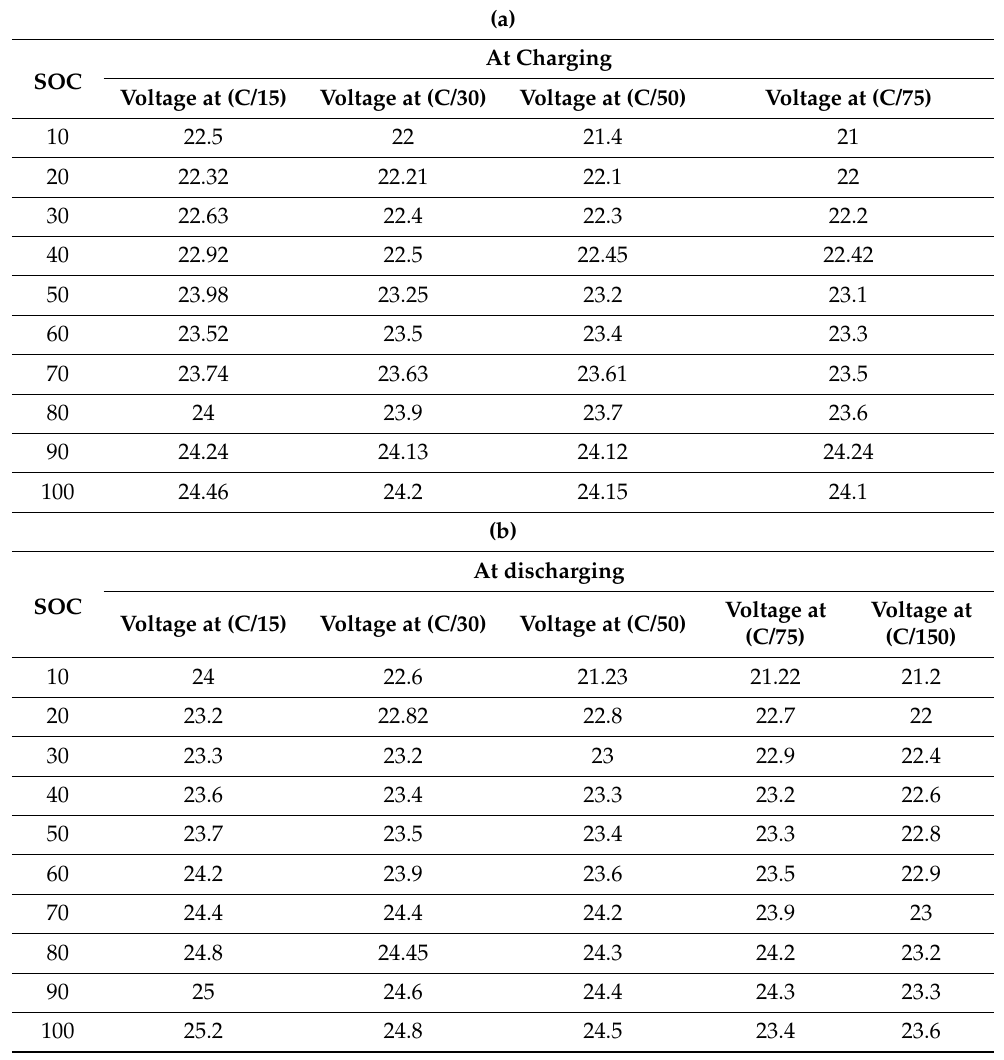
Table 4. ( a ) Battery charging currents; ( b ) battery discharging